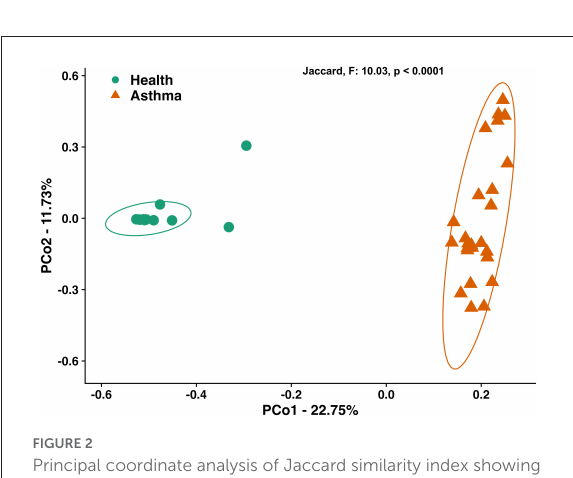
FIGURE2 Principal coordinate analysis of Jaccard similarity index showing significant differences ( p < 0.0001; F = 10.03) in microbial community composition between healthy and spontaneously asthmatic cats. Circles represent healthy cats; triangles represent asthmatic cats and ellipses represent 95%